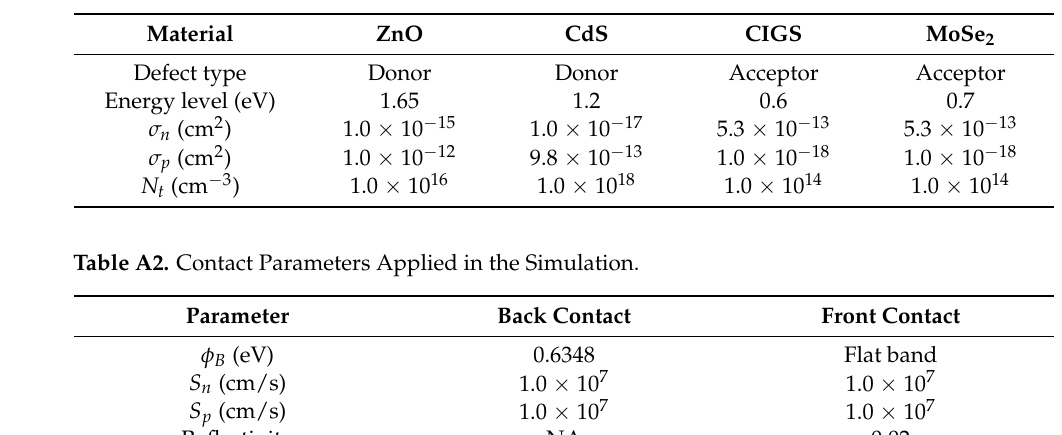
Table A1. Simulation Material Gaussian Defect for the CIGS Solar Cell.